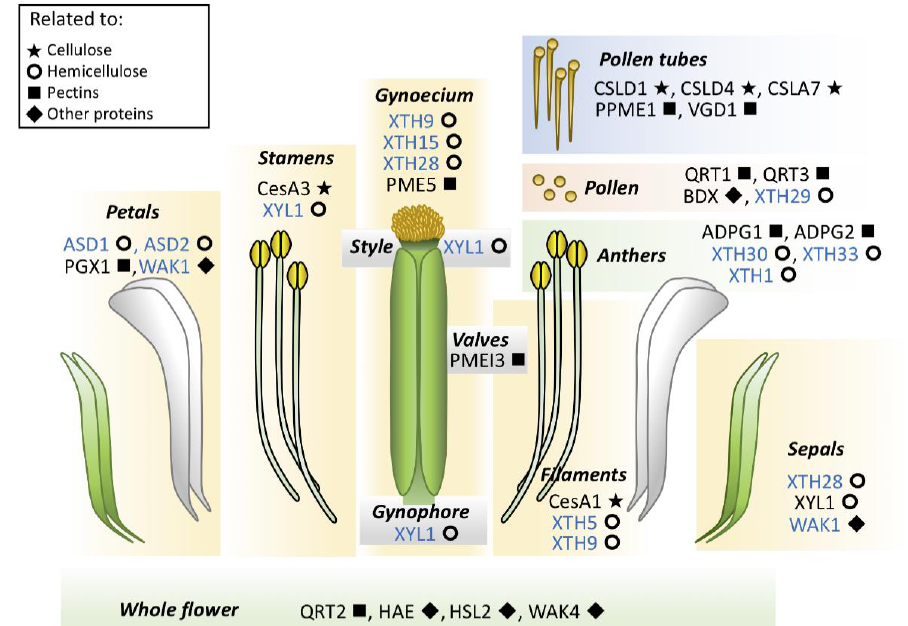
Figure 3. Cell wall-related proteins with a function in the Arabidopsis flower. Functional studies revealed the involvement of enzymes related to cellulose, hemicelluloses, or pectin biosynthesis or modifications during flower development. The function of XTH family members (names in blue color) has only been characterized at the gene expression level. Symbols besides the enzyme name indicate relation with cellulose (stars), hemicelluloses (circles), pectins (squares); or other proteins non-acting on carbohydrates (diamonds). ASD1,2, α -L-ARABINOFURANOSIDASE1, 2; PGX1; POLYGALACTURONASE INVOLVED IN EXPANSION1; WAK1, WALL-ASSOCIATED KINASE1; CesA3, CELLULOSE SYNTHASE A3; CesA1, CELLULOSE SYNTHASE A1; XYL1, XYLOSIDASE 1; PME5, PECTIN METHYL ESTERASE 5; PMEI3, PECTIN METHYL ESTERASE INHIBITOR 3; CSLD1, 4, CELLULOSE SYNTHASE-LIKE D1, 4; CSLA7, CELLULOSE SYNTHASE-LIKE A7; PPME1, PECTIN METHYL ESTERASE 1; VGD1, VANGUARD1; QRT1,2,3, QUARTET1,2,3; BDX, BIIDXI; ADGP1,2, ARABIDOPSIS DEHISCENCE ZONE POLYGALACTURONASE1,2; HAE, HAESA; HSL2, HAESA-LIKE